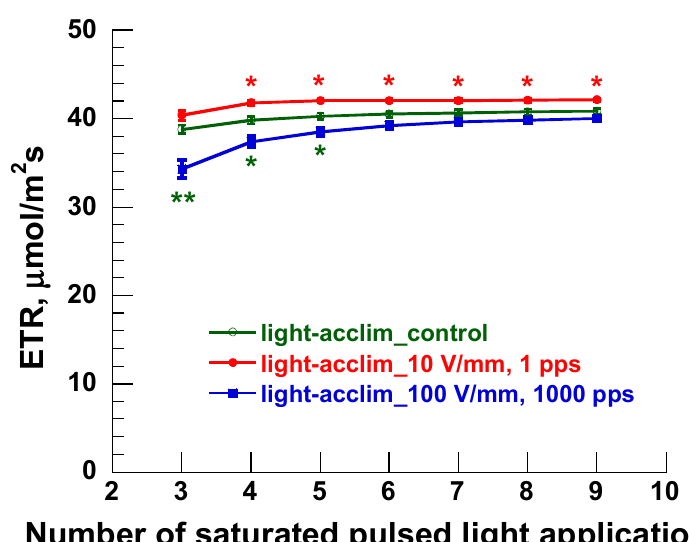
Figure 5. An example of photosynthetic parameters using the combined gas exchange and chlorophyll fluorescence measurements in this study. ETR results are given at each measurement time point (No.) for different PEF treatment conditions on light-acclimated samples. The asterisks * and ** indicate significant differences at p < 0.05 and p < 0.01, respectively.